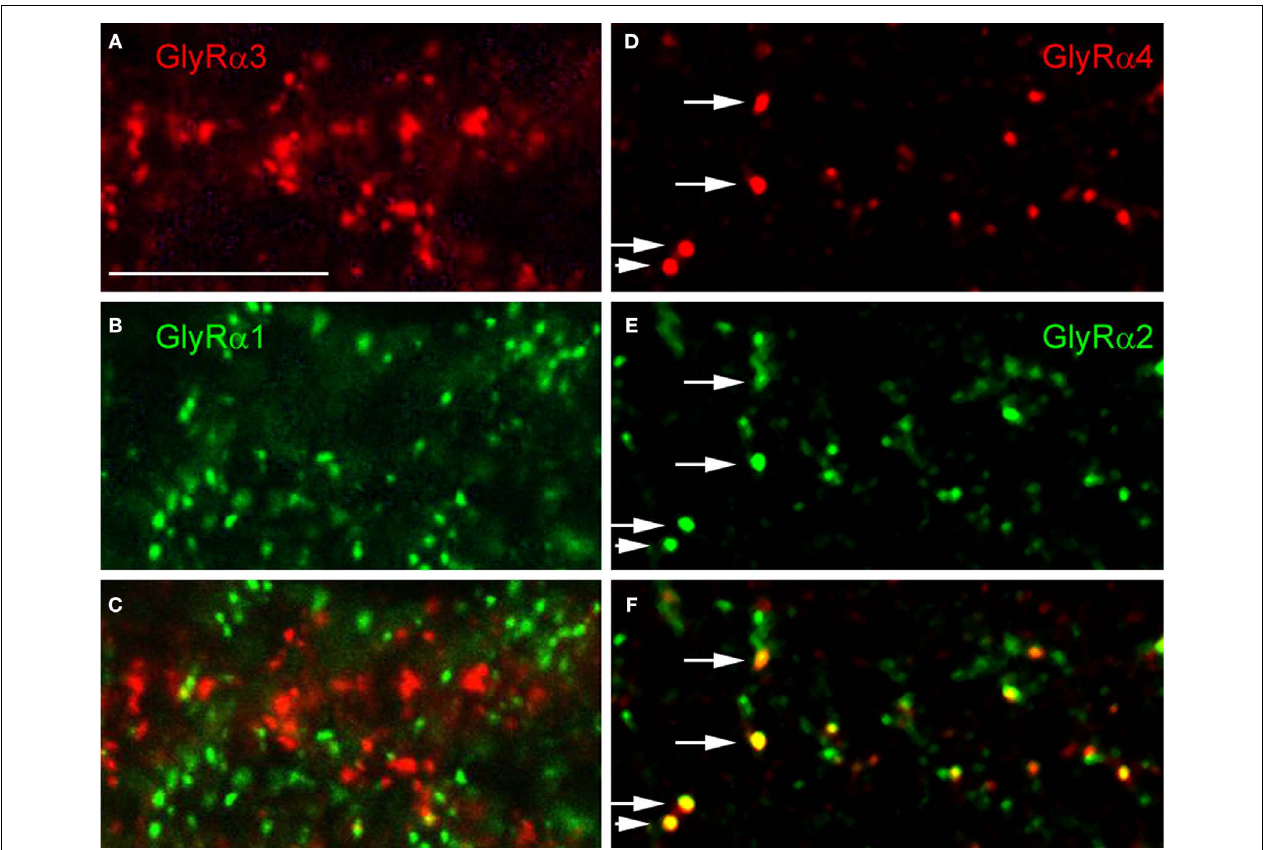
FIGURE 4 | Colocalization of GlyR subunits at postsynaptic sites (modifi ed from Haverkamp et al., 2003; Heinze et al., 2007). (A) GlyR α 3 immunoreactive puncta. (B) Same section as in (A) , immunostained for GlyR α 1. (C) Superposition of (A) and (B) shows that GlyR α 3 and GlyR α 1 immunoreactive puncta are not